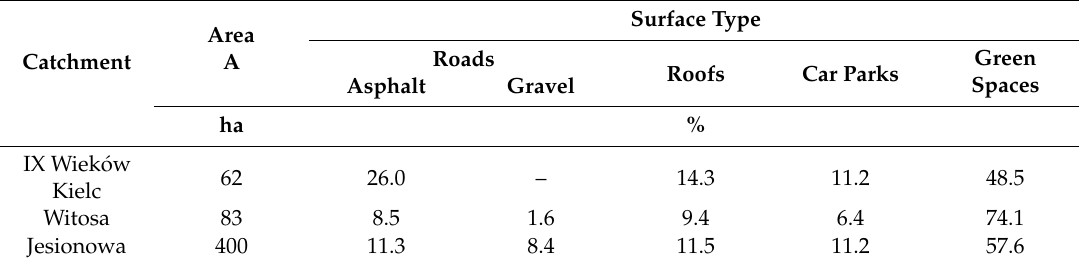
Figure 1. Study area—( a ) location in the city of Kielce; ( b ) IX Wieków Kielc stormwater treatment plant (SWTP) catchment; ( c ) Witosa SWTP catchment; and ( d ) Jesionowa SWTP catchment. Table 1. Land use